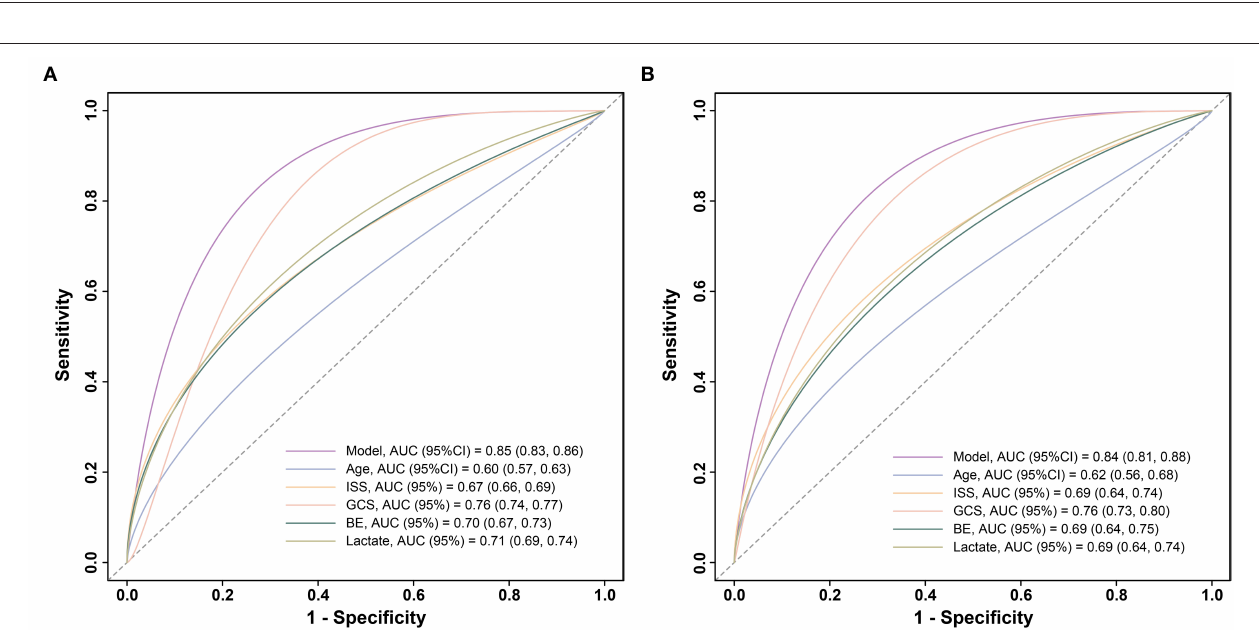
FIGURE 4 | Calibration plots of the model for predicting 72-h mortality in patients with polytrauma (A) in the training cohort ( n = 2461) and (B) in the validation cohort ( n = 614). ROC, receiver operator characteristic.